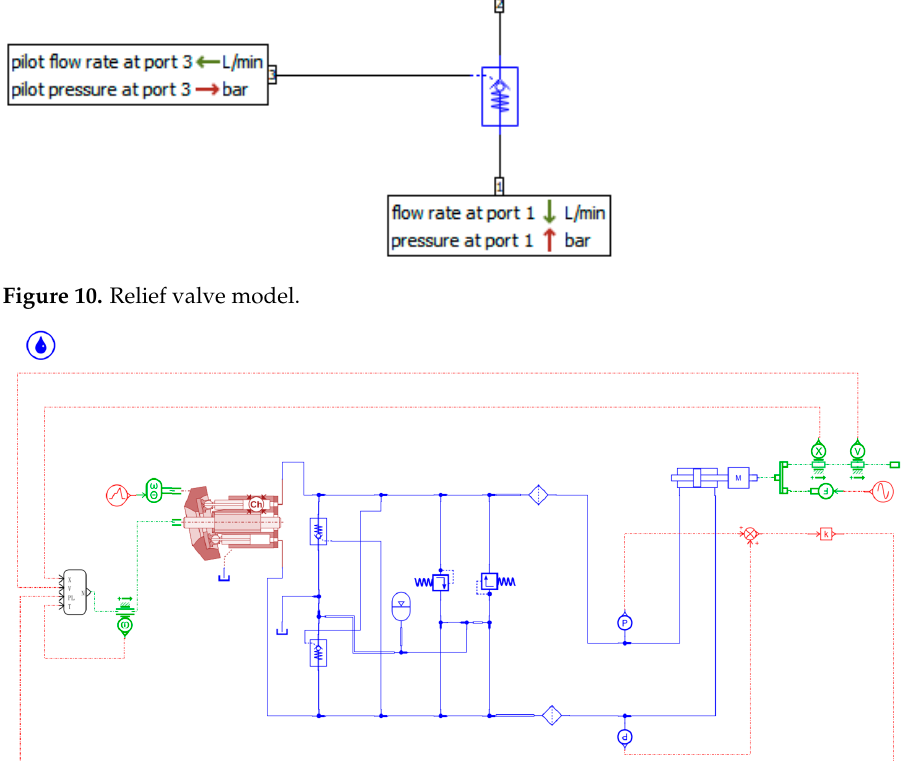
Figure 11. Simulink–Amesim co-simulation Amesim model. Meanwhile, the permanent magnet synchronous motor and system controller mod- els are established in Matlab/Simulink as shown in Figure 12, and then the co-simulation model of mechanical, hydrostatic and control subsystems of EHA is established between AMESim and Matlab/Simulink through the interface block. The controller model consists of three adaptive fuzzy PID controllers, namely speed loop fuzzy PID, q -axis current loop fuzzy PID and d -axis current loop fuzzy PID. It works by using a fuzzy PID controller to generate 𝑢 (cid:3044) and 𝑢 (cid:3044) commands based on the difference between the actual feedback cur- rent of the motor and the reference current, thus controlling the motor output speed. It is worth mentioning that both the output speed and the feedback displacement signals are transmitted by the joint simulation interface block interface module. Based on the co-sim- ulation of these two software, a realistic and accurate simulation of the complex operating conditions of the EHA is achieved, which lays the foundation for further research on the control method of the system drive unit. The EHA system for a high-speed micro-compact quantitative axial piston pump driven by a permanent magnet synchronous motor with a sinusoidal counter-potential has been developed for current applications. The speed control of the hydraulic actuator is achieved using the speed control of the servo motor and the commutation of the servo motor achieves the commutation of the hydraulic actuator. The parameters of the EHA system used in this paper are shown in Table 2.